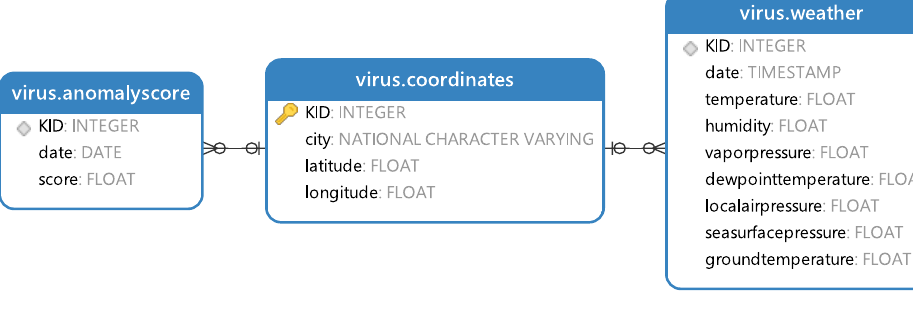
Figure 2. Relationship between the